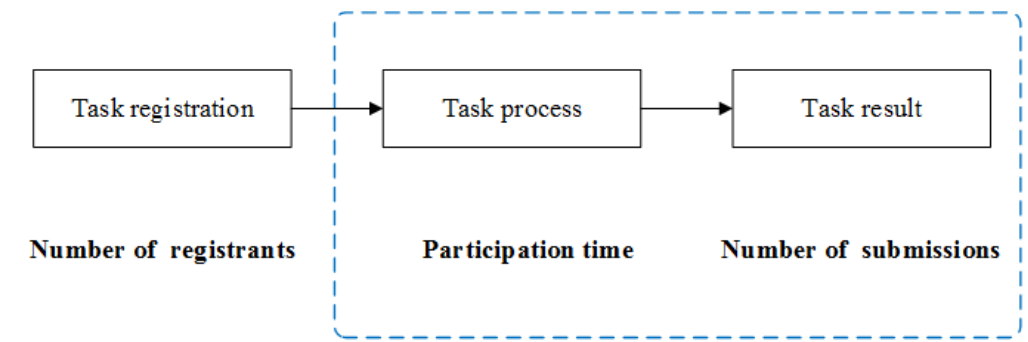
Figure 1. Crowdsourcing contest stages and solvers’ participation behavior. Source: This and all other figures were created by the authors.